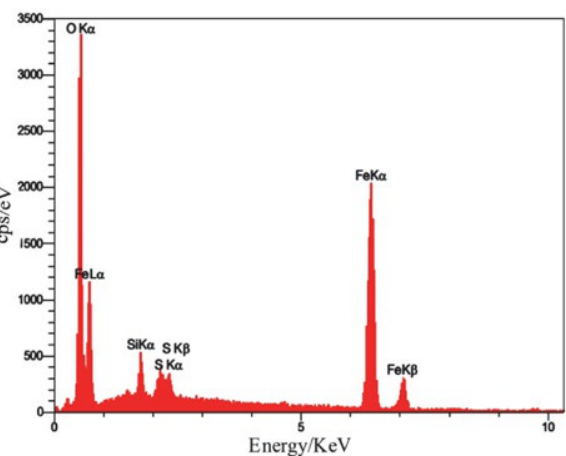
Figure 3 . The EDX spectrum of Fe